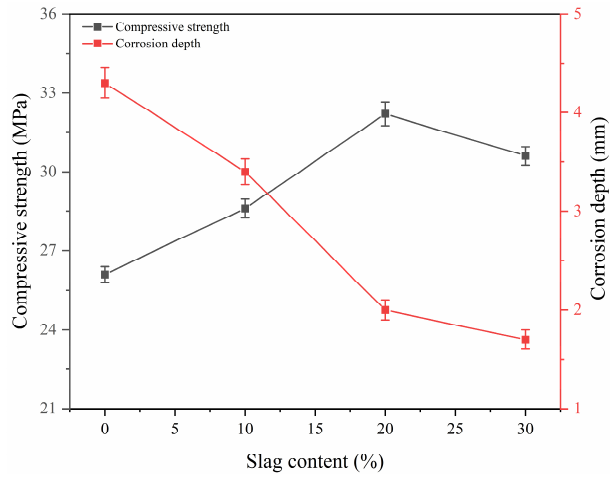
Figure 6. E ff ect of slag on cement slurry performance. Figure 6. Effect of slag on cement slurry performance.